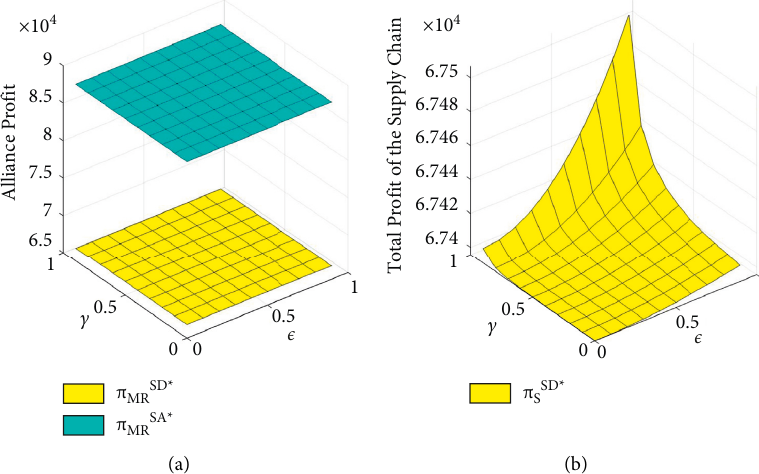
Figure 8: The effect of c and ϵ on alliance profits and total profit (a) the impact on alliance profits (b) the impact on the total profit of the supply chain (SD as an